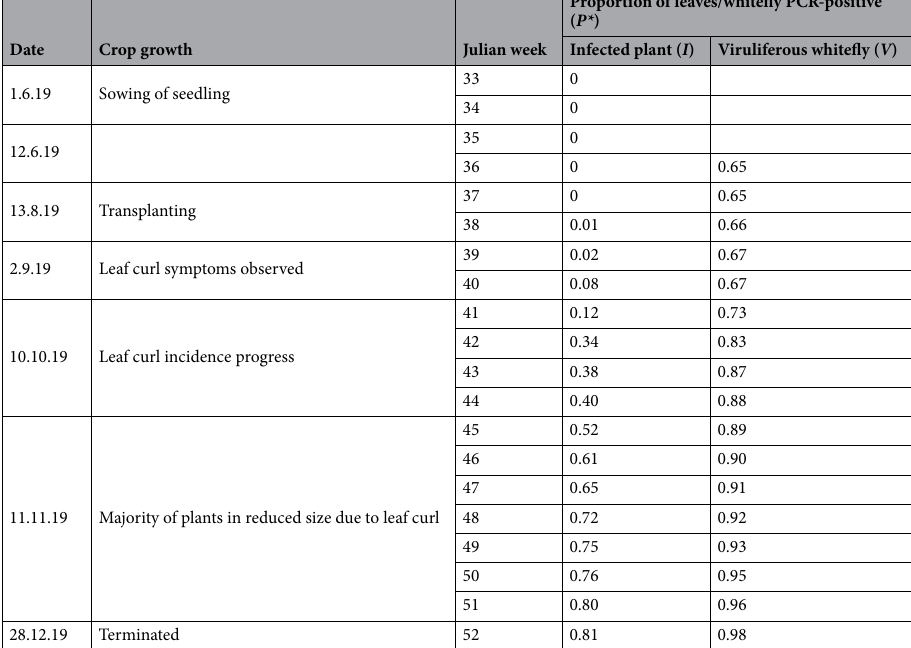
Table 1. Proportion ( P ) of infectedchilli plant ( I ) and viruliferous whitefly ( V ) population tested PCR- positive a at IARI-New Delhi experimental field, on cvHPH-1041 (Syngenta), transplanted in 2019. a Chili leaves or whiteflies were tested by PCR with universal primers to ChiLCV. *P = 1 − ((n − X)/n) 1/m where n = number of groups for the leaves or whiteflies; m = number of leaves or whiteflies in each group; X = number of groups tested PCR- positive.